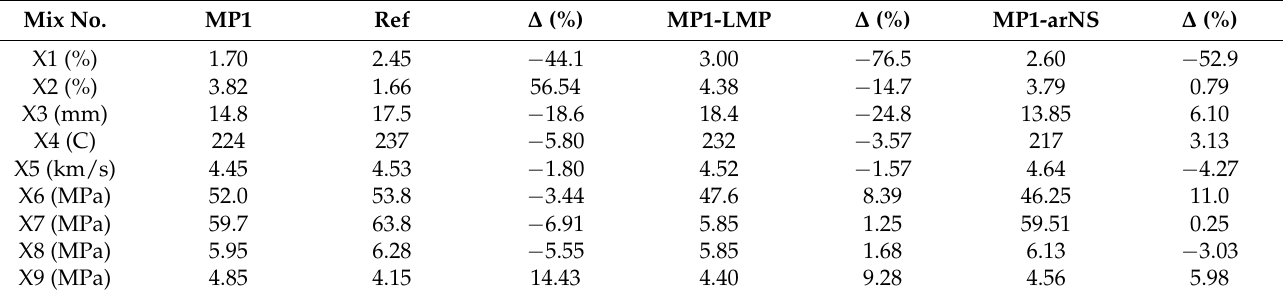
Table 12. Performance benchmark of optimized MPFA